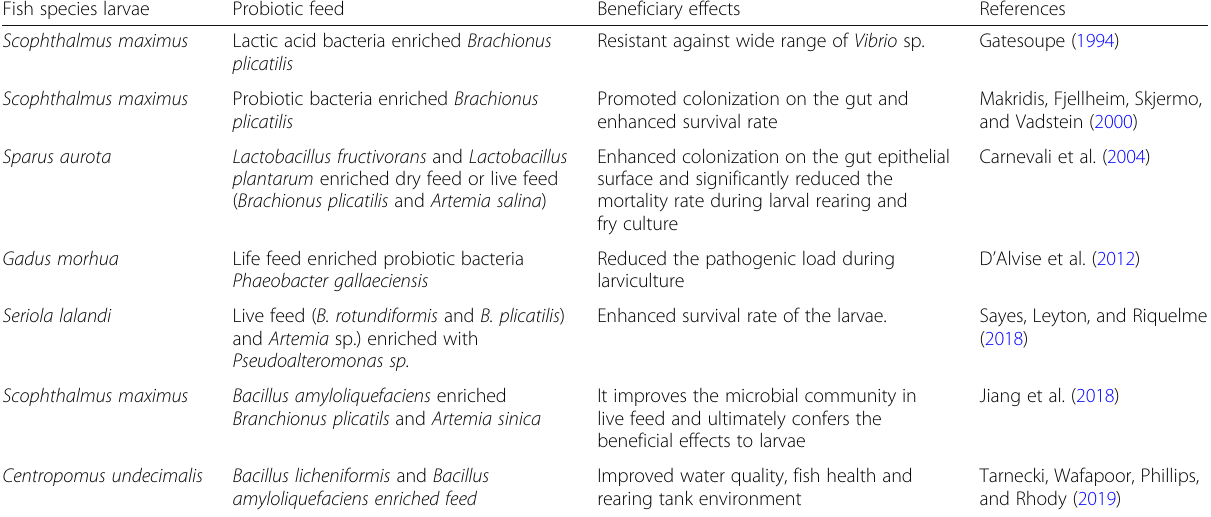
Table 6 Interaction between probiotics and different types of food in fish farming Fish species